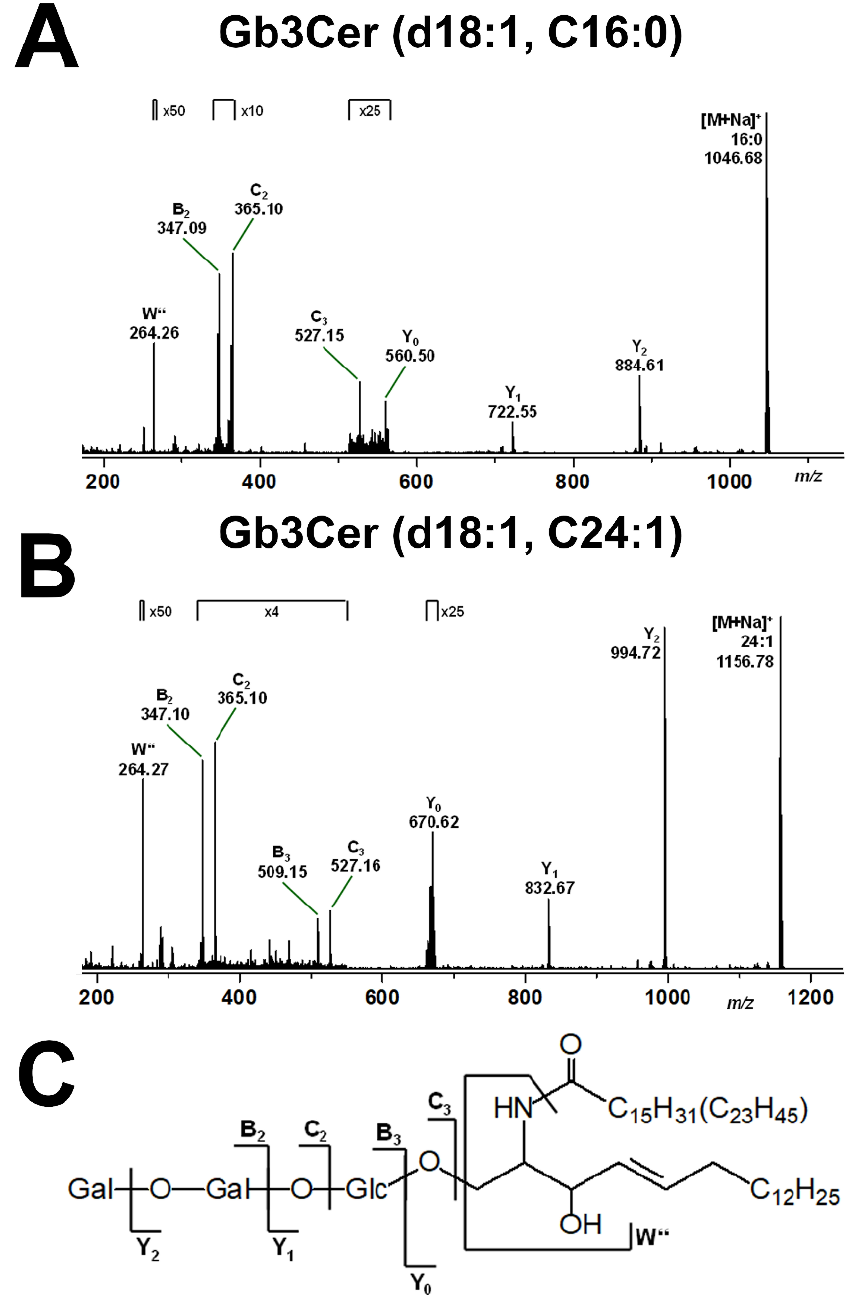
Figure 3. MS 2 spectrum of selected Gb3Cer (d18:1, C16:0) ( A ) and Gb3Cer (d18:1, C24:1) ( B ) obtained from serum-free cultivated pHCoEpiCs and the explanatory fragmentation scheme ( C ). The MS 2 spectra were obtained from a GSL preparation of replicate 1 (R1; see Figure 1) using the positive ion mode. [M+Na] + adducts of the various Gb3Cer lipoforms harboring sphingosine (d18:1) and variable fatty acids as indicated were fragmented by means of collision-induced dissociation (CID).